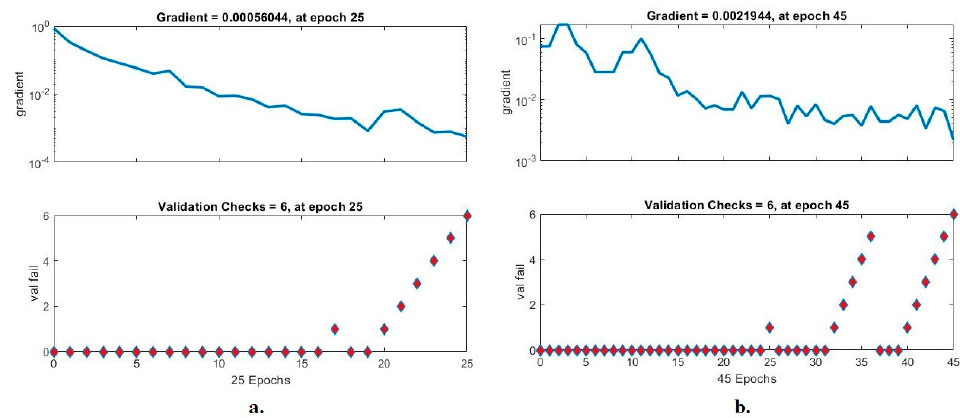
Figure 13. The GVC for diagnosing X-ray images of pneumonia and tuberculosis using the ANN with features ( a ). VGG16 and LDG; ( b ). ResNet18 and LDG.